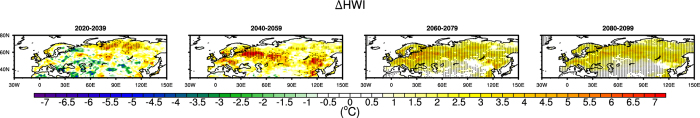
Same as in Fig. 1 except showing the change in heatwave intensity (HWI). This figure was created using NCLV6.2.1 (http://www.ncl.ucar.edu/).